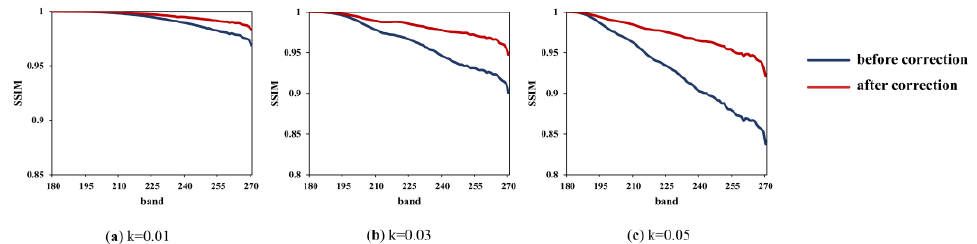
Figure 11. SSIM of each band between original image and images with k of ( a ) 0.01; ( b ) 0.03; and ( c ) 0.05.